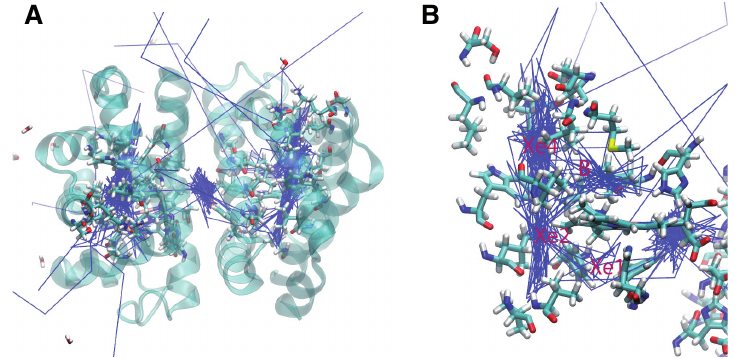
Figure 2. A. The trajectories for 14 oxygen molecules during a 10 ns simulation of the wildtype HbI are shown in blue. The main escape pathways are between the B and G and the E and F helices. One oxygen crossed over the subunit interface and another remained in the interface. B. The internal cavities are revealed through the presence of the dense trajectory paths. The B, Xe4, Xe2, and Xe1 cavities are